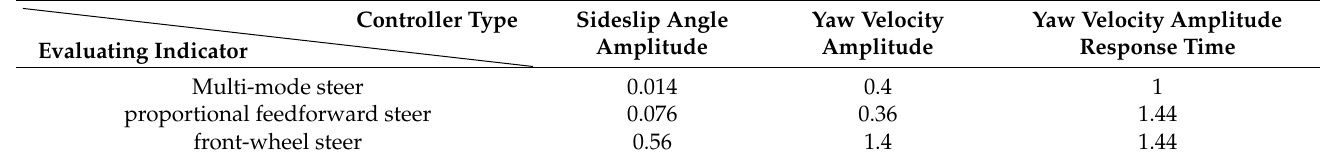
Figure 17. Simulation comparison under sine condition. ( a ) Sideslip angle. ( b ) Yaw rate. ( c ) Lateral acceleration. Table 6. Response indicators under sine